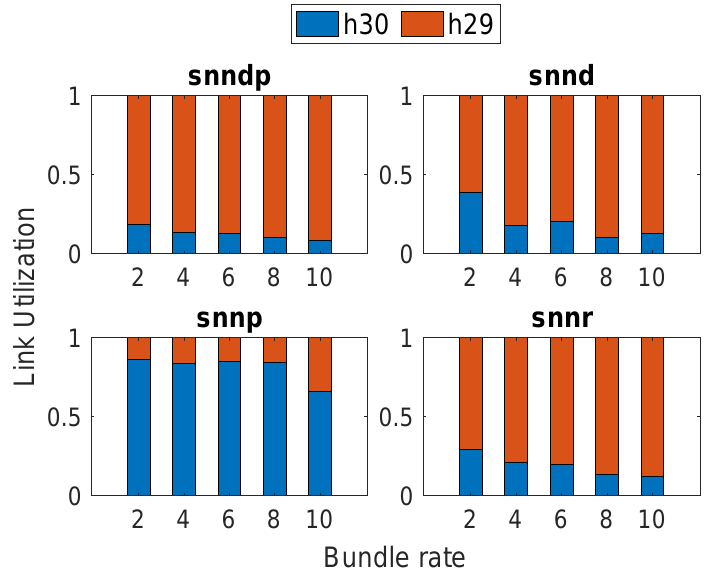
Figure 8. Link selection at Node h26: Scenario 3.